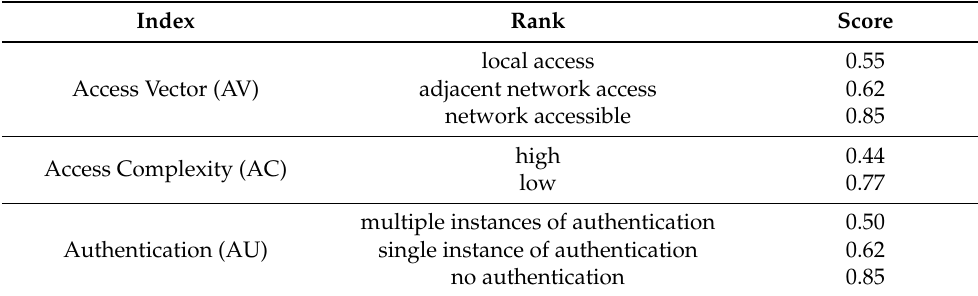
Table 1. CVSS Score (base